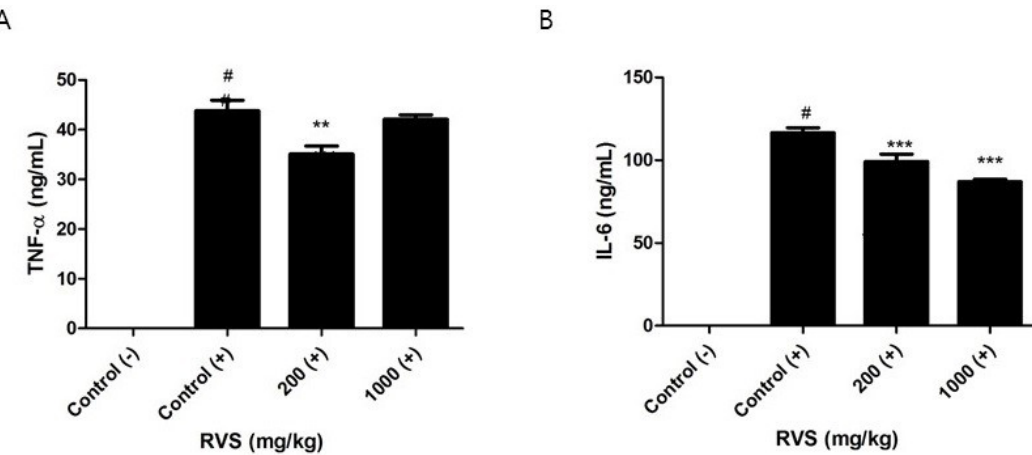
Figure 3. Effects of RVS extract on tumor necrosis factor (TNF)- α and interleukin (IL)-6 levels in the supernatants of lipopolysaccharide (LPS)-stimulated peritoneal macrophages. Adherent peritoneal macrophages isolated from mice orally given RVS extract were stimulated with LPS for 24 h, and the concentrations of TNF- α ( A ) and IL-6 ( B ) were measured using enzyme-linked immunosorbent assay (ELISA). The bars represent the mean ± SEM ( N = 6). ( − ): without LPS, (+): with LPS. Statistical differences between groups were determined using one-way ANOVA with Tukey’s test. # p < 0.005 vs. control ( − ). ** p < 0.01, *** p < 0.005 vs. control (+).